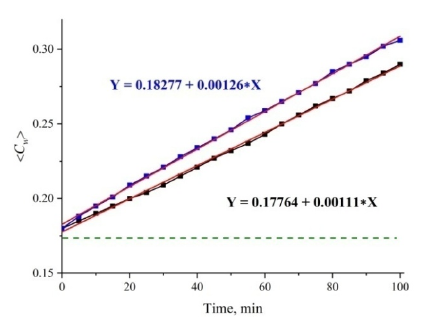
Figure 11. Average (over the distance L = 200 μm between the windows of the cell) concentration of water C w ( t ) vs. the time of swelling for two cells with different roughness of the windows. The upper line is approximated by function Y = 0.18277 + 0.00126 X; the lower line is approximated by function Y = 0.17764 + 0.00111 X. The dashed line is the water concentration for dry Nafion (baseline).